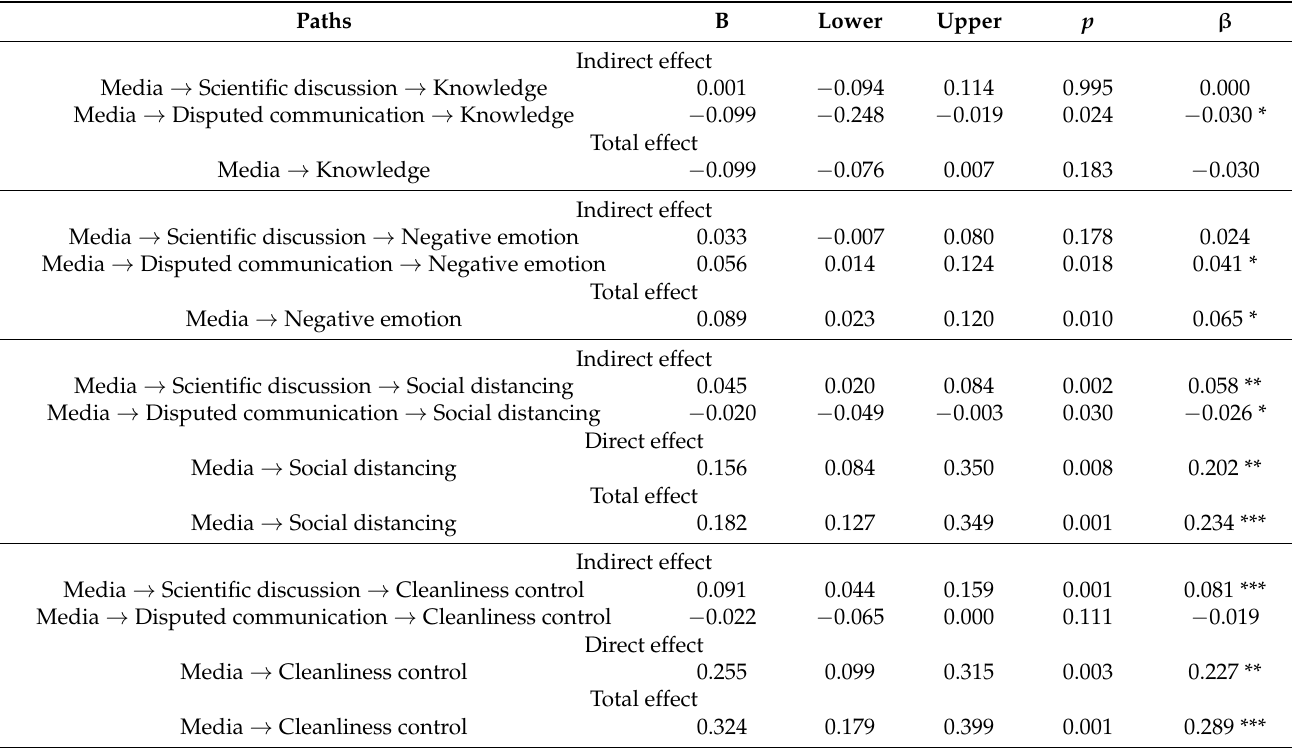
Table 3. Influence of media on elderly people’s health-related outcomes. Paths B Lower Upper p